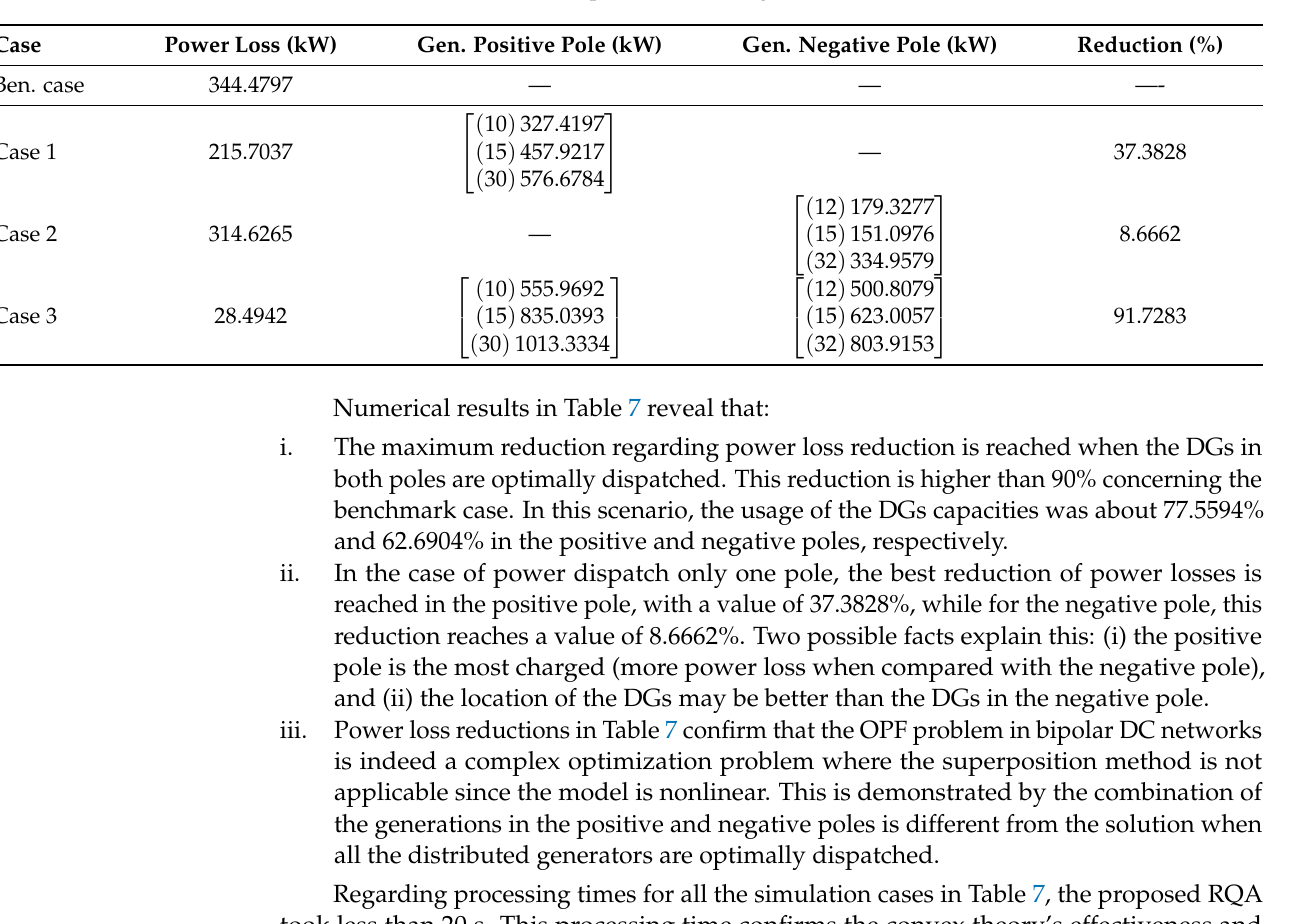
Table 7. OPF solution for the bipolar DC 33-bus